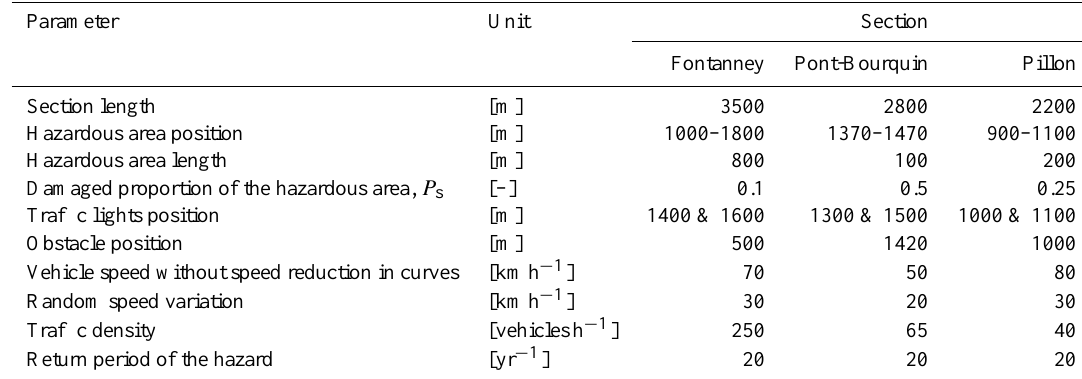
Fig. 5. Illustration of the three scenarios on the Fontanney section with corresponding speed graphics of lane 2. The caution panels indicate the beginning and the end of the hazardous area. Vehicles are represented by circles, red for the lane 1 (uphill) and blue for the lane 2 (downhill). (a) Scenario 1: road without obstacles or traffic limitations. Vehicle speeds vary only in function of the road geometry. (b) Scenario 2: traffic regulated by traffic lights. A vehicle tailback forms behind the red traffic light (lane 2) while the vehicles on lane 1 cross the hazardous area. Vehicle speeds fall down to zerokmh − 1 during 20 s before increasing after the traffic light turns to green. Table 3. Parameters for the